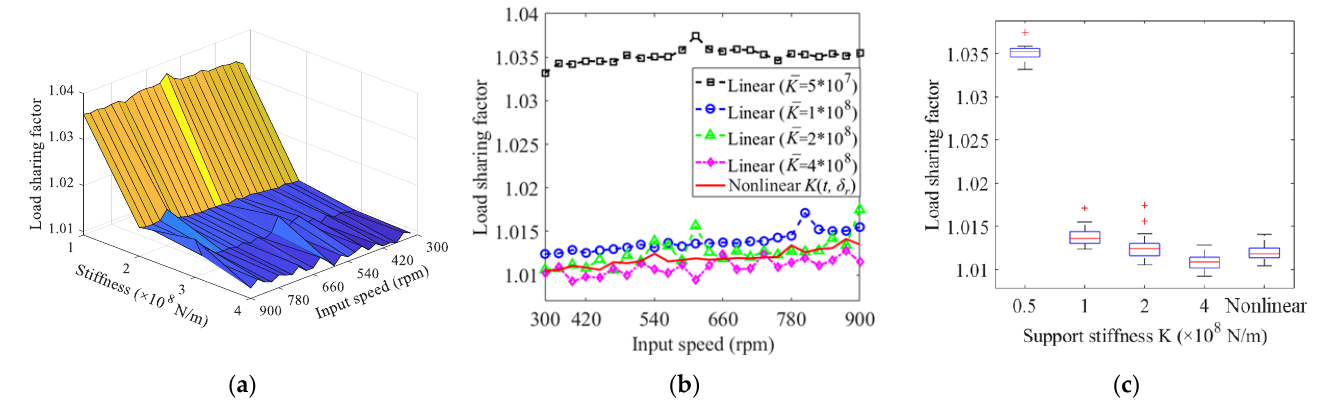
Figure 16. Load-sharing factors of sun-planet gear pair of different support stiffness under input speed in 300-900 rpm: ( a ) 3D view, ( b ) front view, and ( c ) boxplot.